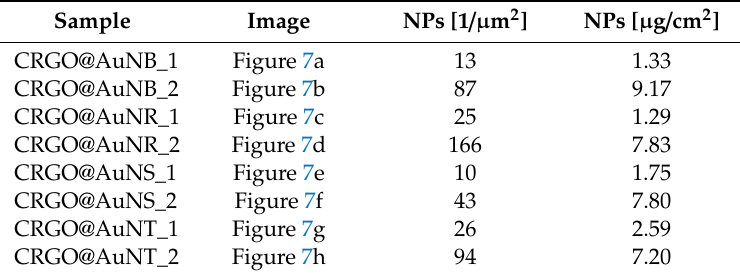
Figure 7. TEM micrographs of GNP composites based on anisotropic nanoparticles. Samples obtained using: ( a , b ) bipyramid; ( c , d ) nanorods; ( e , f ) nanostars; and ( g , h ) nanotriangles. Two densities of grafting are shown: lower and higher in upper and lower rows, respectively. Insets in panels ( a , c , e , g ) show magnified areas of the composites to clearly evidence shapes of nanoparticles. Additional images of these composites are shown in Figures S2-S5. Scale bars correspond to 1000 nm. Table 1. Estimation of anisotropic nanoparticles’ density on